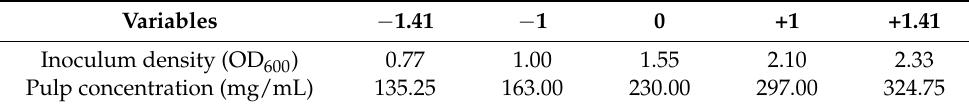
Table 1. Coded and decoded levels of independent